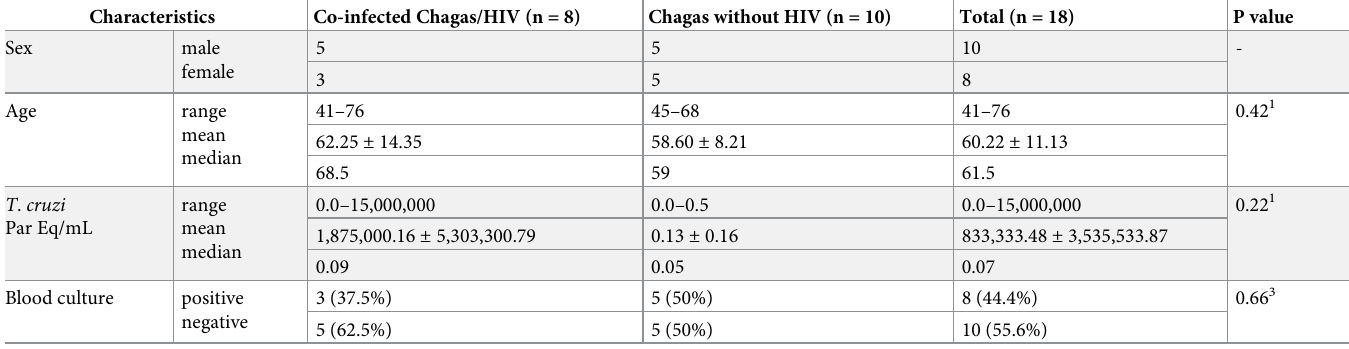
Table 3. Statistical analysis—Co-infected Chagas HIV and patients without HIV.